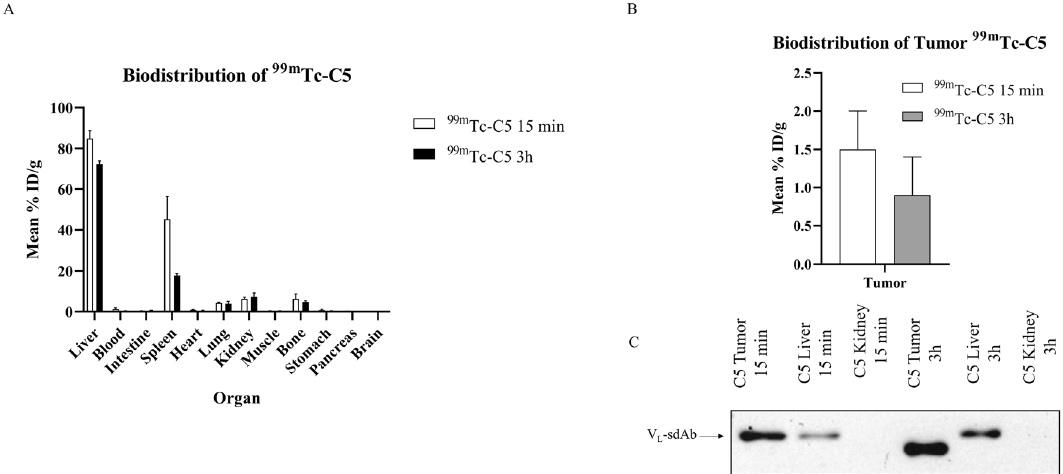
Figure 5. Biodistribution profile of 99m Tc-C5. To evaluate the tumoral uptake and pharmacokinetic profile of the C5 VL sdAb, a biodistribution assay was performed on a xenograft model of cNHL at two different time points (15 min and 3 h). C5 was radiolabeled with 99m Tc(CO) 3 (H 2 O) 3 and intravenously injected in the tail vein of a xenograft mouse model of cNHL. Mice were sacrificed at 15 min and 3 h, and the radioactivity of each organ was measured. The activity in each organ was calculated and expressed as a percentage of injected radioactivity dose per gram of organ or tissue (%ID/g). ( A , B ) The results show that the tumoral uptake was around 1.5 ± 0.5%ID/g at 15 min, diminishing to 1% at 3 h after injection. A fast elimination in the major organs was noticed, with exception of the liver and spleen. ( C ) The results were also confirmed by western blot analysis. C5 was recovered from the mice organs by immunoprecipitation with His beads and analysed by western blot. Samples were loaded in a 15% SDS page acrylamide gel. Following gel transfer and blocking, the membrane was incubated with HRP-conjugated anti-His antibody (1/3000). Protein detection was performed by chemiluminescence using Luminata ForteWestern HRP and acquired using the ChemiDoc XRS + imaging system (Bio-Rad). This analysis confirmed the presence of the C5 VL sdAb in CLBL-1 xenograft tumors at 15 min and 3 h. Representative blots are shown. Image is part of the original blot, which is depicted in Supplementary Fig.